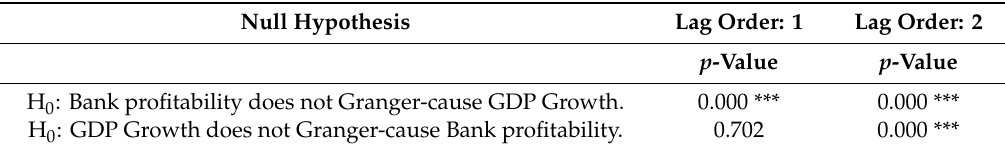
Table 8. Granger causality